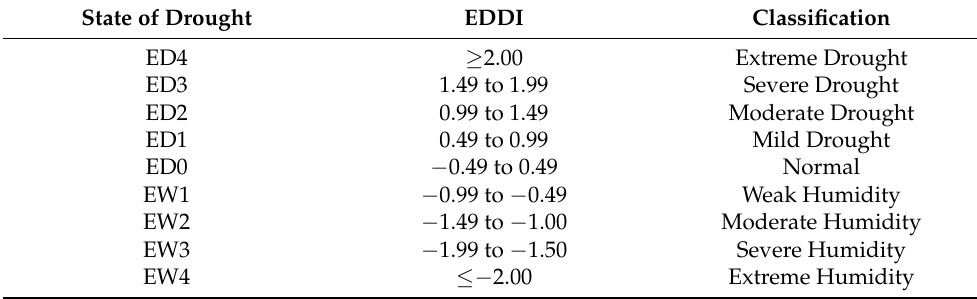
Table 5. EDDI Classification. State of